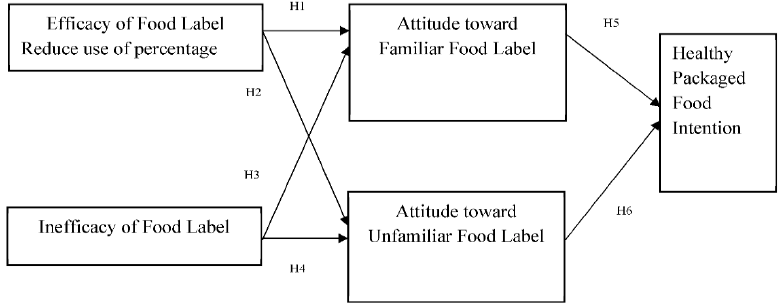
Figure 1. Food labeling and consumer intention for healthy package